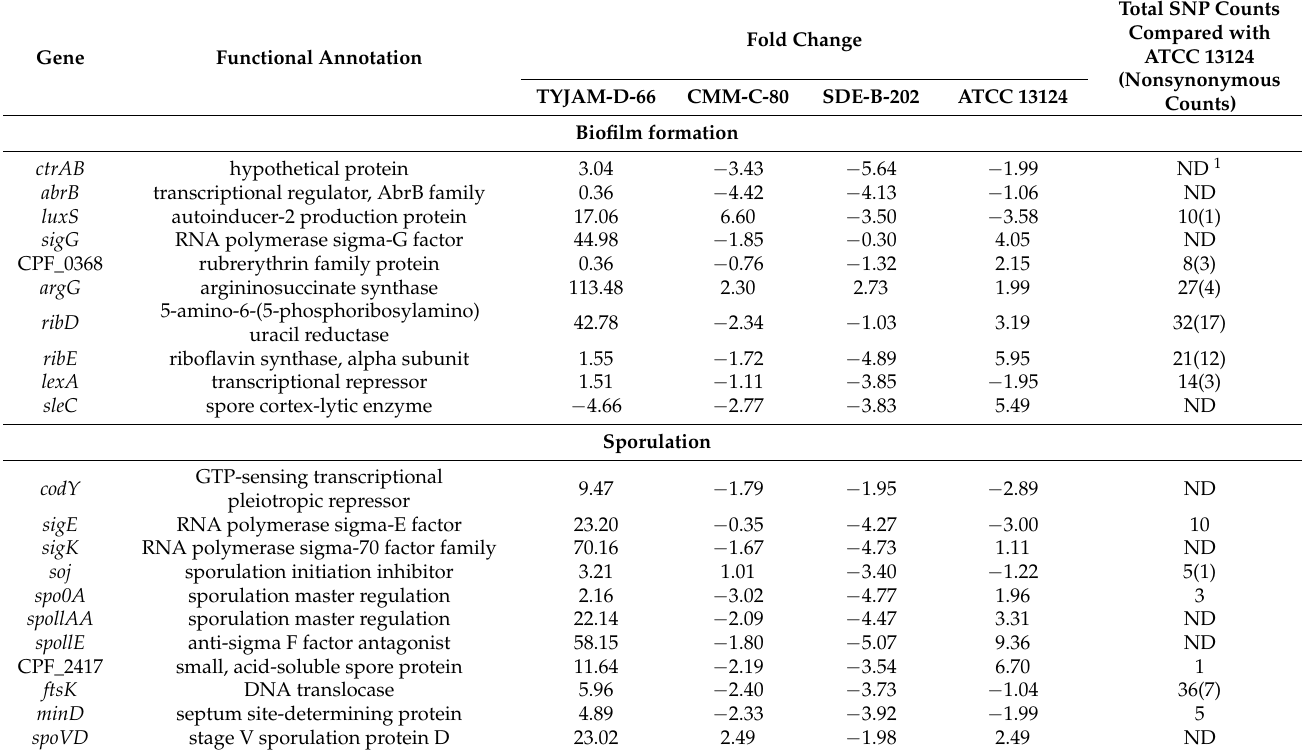
Table 1. Fold changes in biofilm formation and sporulation-related gene transcription in C. perfringens biofilms.